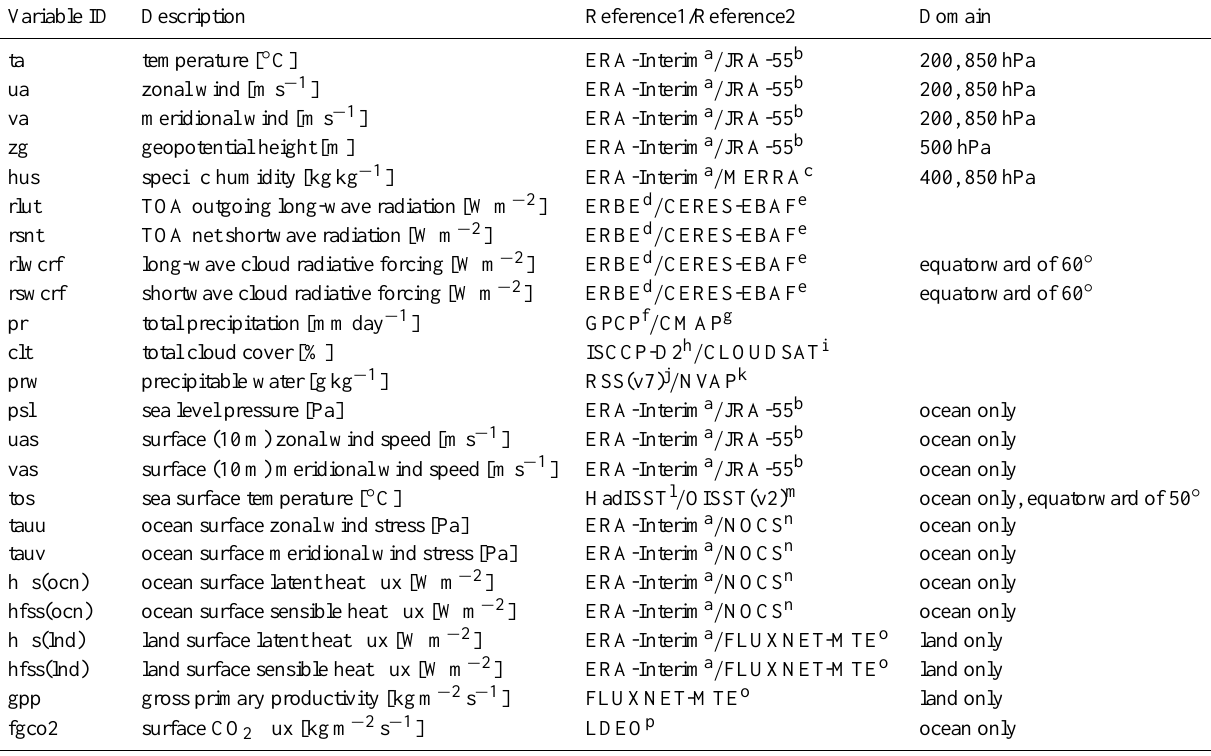
Table 1. Observationally based reference data